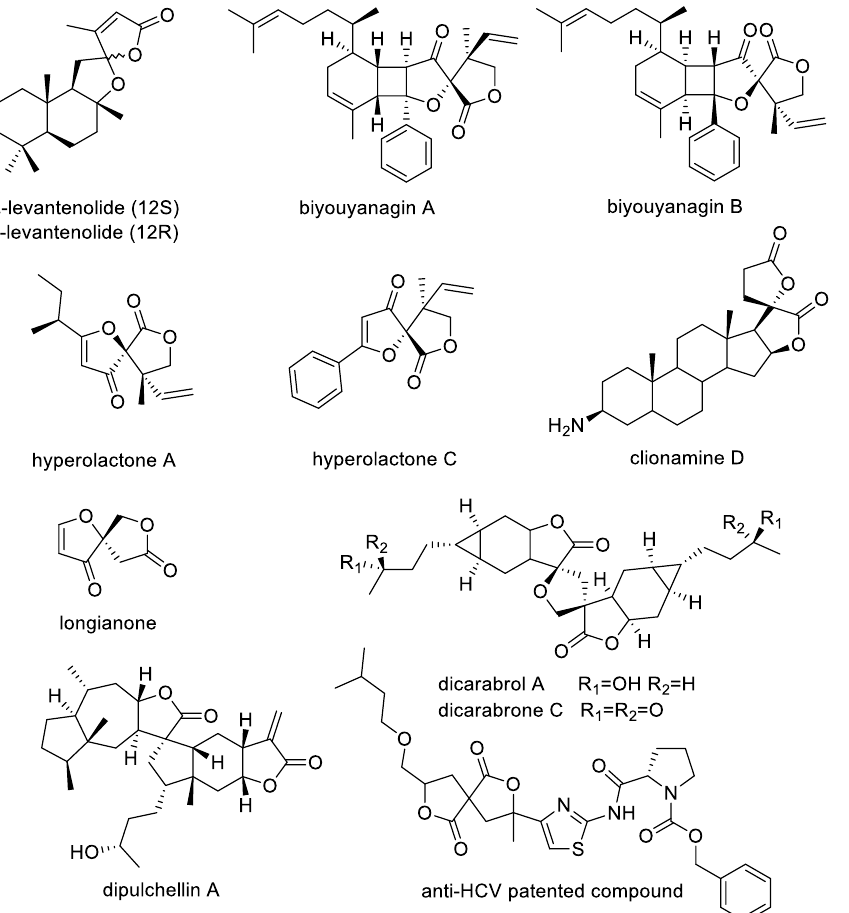
Figure 1. Bioactive natural and synthetic products containing spirobislactone moiety or similar scaf- fold.